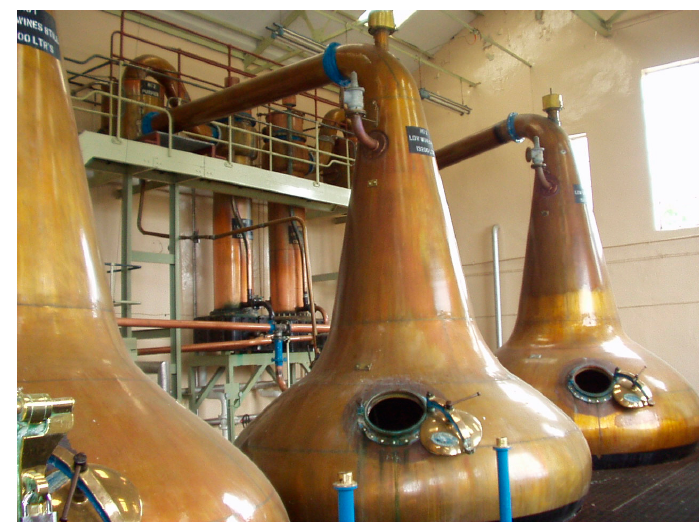
Figure 22. A typical pot still employed for the batch distillation of malt whisky.